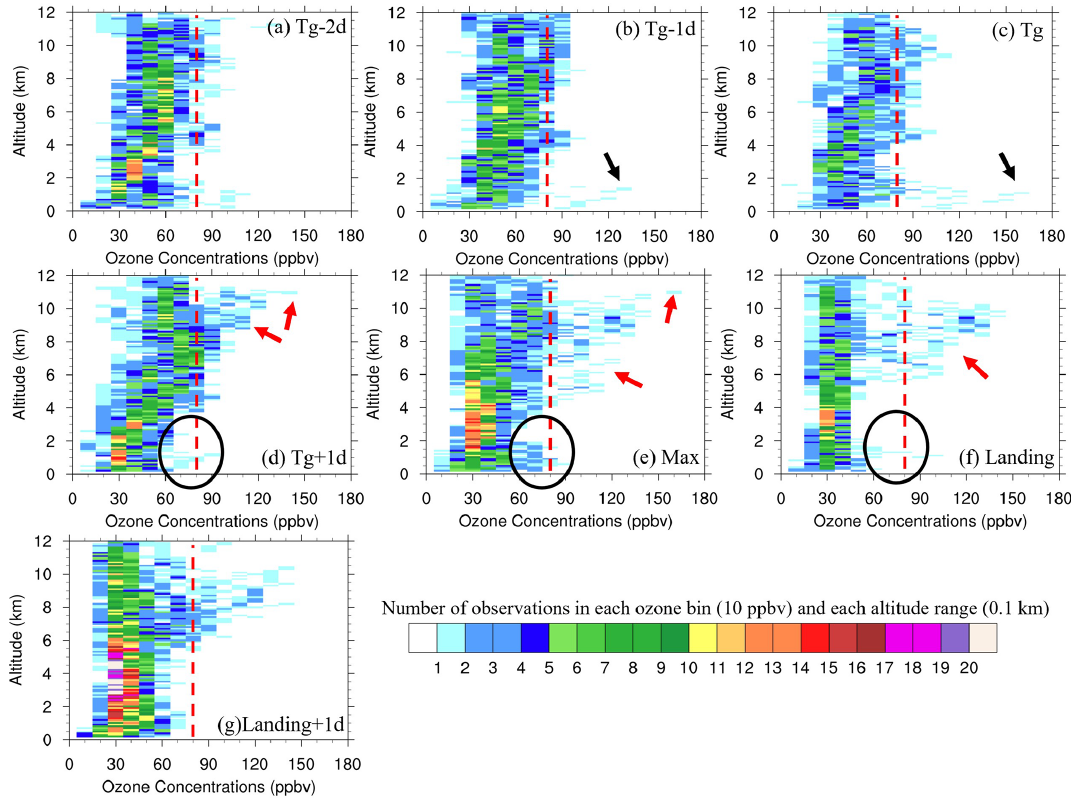
Figure 7. Number of ozone concentrations (every 10ppbv) in each vertical layer (with a 100m spacing) at different developmental stages of typhoons. The red dashed lines of 80ppbv represent ozone-rich air masses with a stratosphere origin based on the averaged results from Fig.